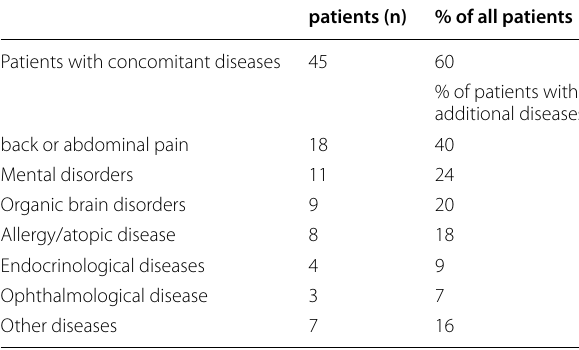
Time trends in headache days were investigated using Table 1 Frequency of additional diseases a linear mixed-effects model with random intercept per patient and fixed effects for gender, time point, and patients (n) % of all main diagnosis. This analysis arrived to similar conclu- sions, indicating a strong reduction in headache days.